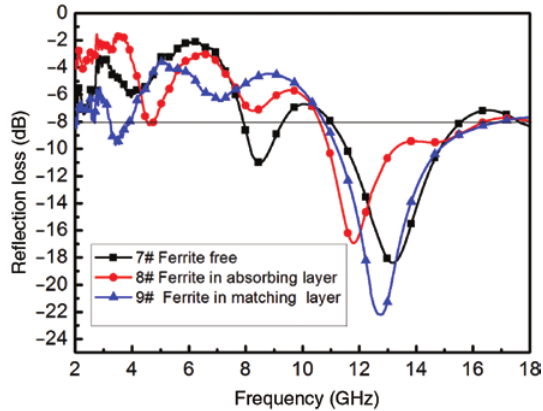
Figure 7: Reflection loss of double-layer cement samples with dif- ferent replacement level of FA in absorbing layer.